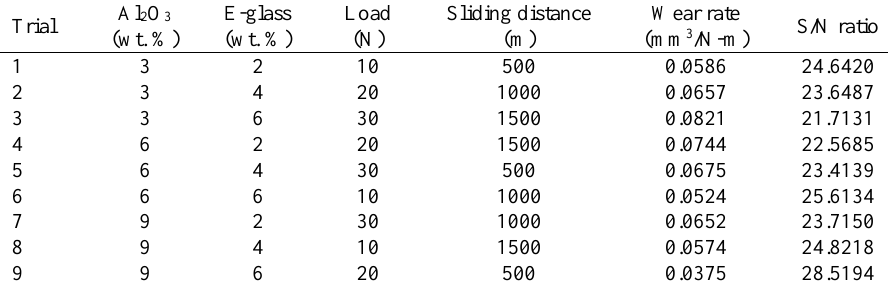
Table 2. The results of the Taguchi wear test in the L9 orthogonal array with the S/N ratio.